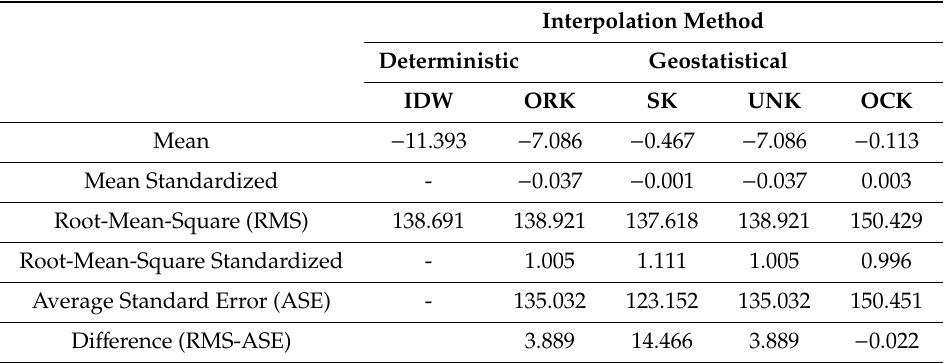
Table 2. Output displaying the statistics of deterministic and geostatistical interpolation methods used to create precipitation grids based on all available data collected from weather stations in Georgia managed by the University of Georgia Weather